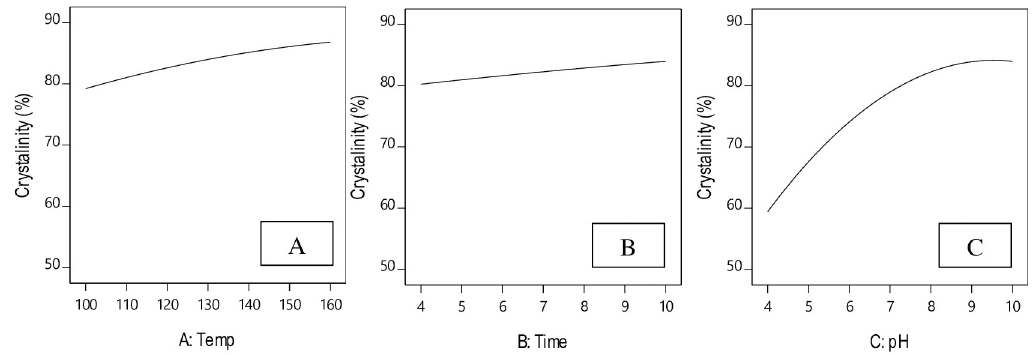
Fig 8. Effect of process parameters on degree of crystallinity. A: Hydrothermal temperature, B: hydrothermal reaction time, C: pH.